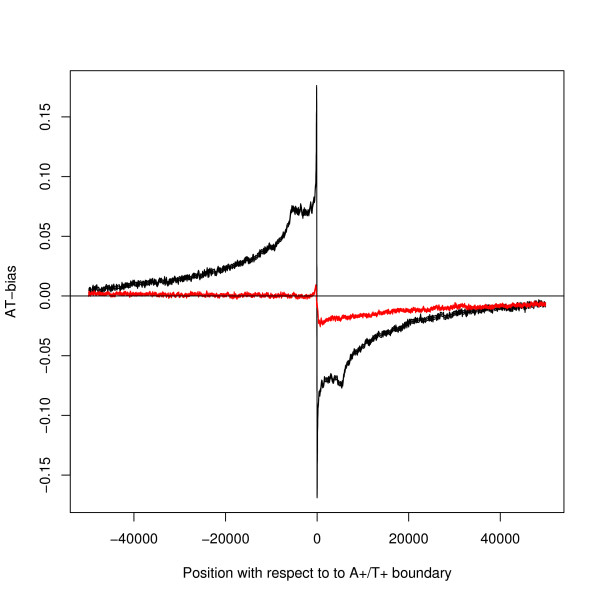
A comparison of segment bias and transcription bias. The black line shows the AT-bias about the A+/T+ boundary. The red line shows the AT-bias for genes aligned by their TSS: for this line the x-axis gives the position relative to the TSS. Both lines show moving averages over 100 bases. The thickness of both lines show 95% confidence limits. There is a statistically significant difference between the two lines: at position 5000 bases downstream of the boundary a two-tailed z-test gives p-value < 10-50 n1 = 11750, n2 = 23941, z = -63.